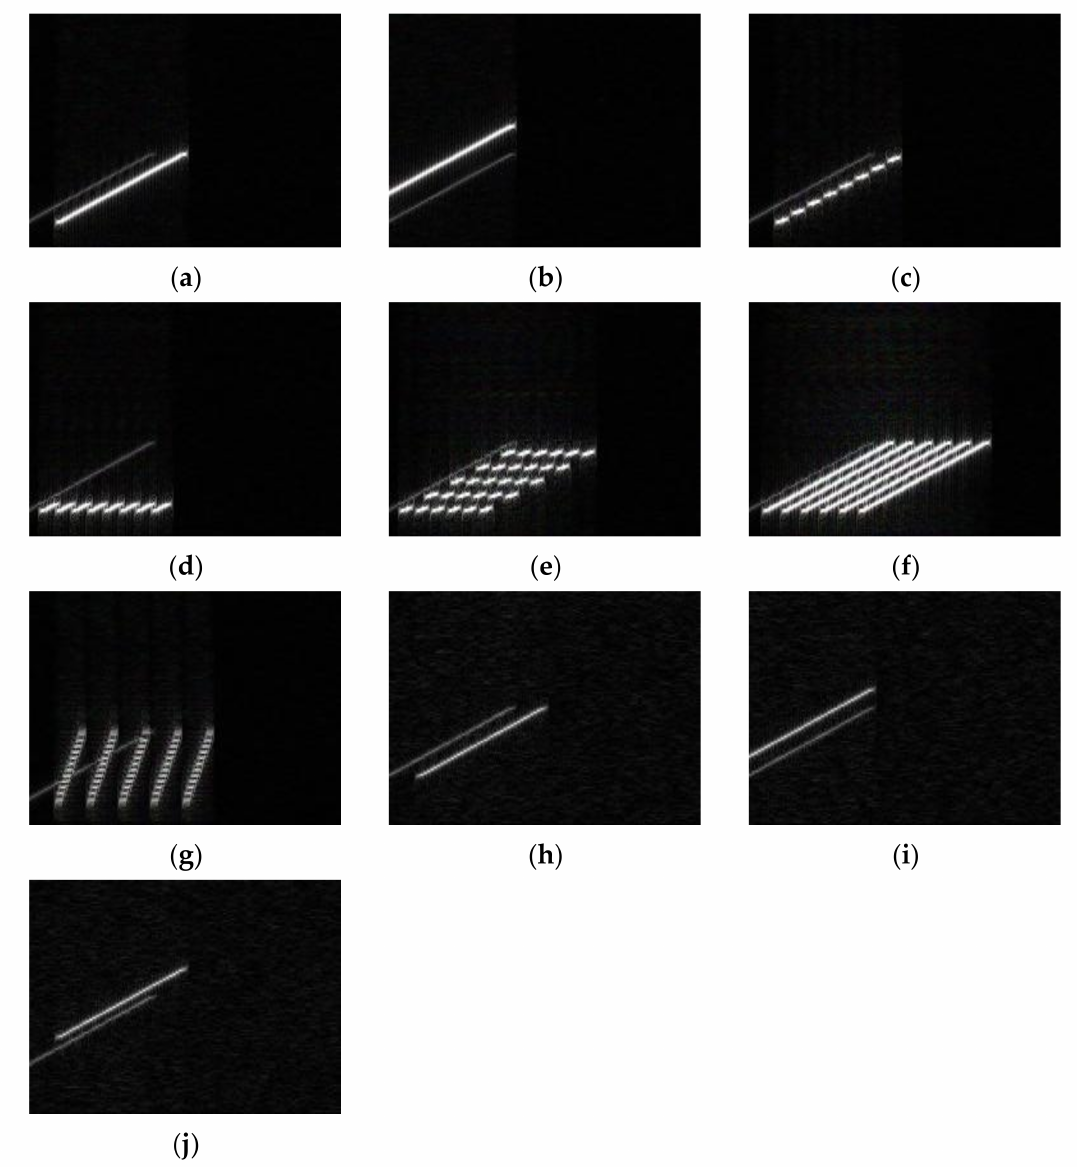
Figure 5. Time–frequency diagram of jamming plus echo. ( a ) RFTJ + echo. ( b ) VFTJ+ echo. ( c ) ISDJ + echo. ( d ) PDTJ + echo. ( e ) ISRJ + echo. ( f ) WDTJ+ echo. ( g ) SMSP + echo. ( h ) RGPO + echo. ( i ) VGPO + echo. ( j ) R-VGPO +